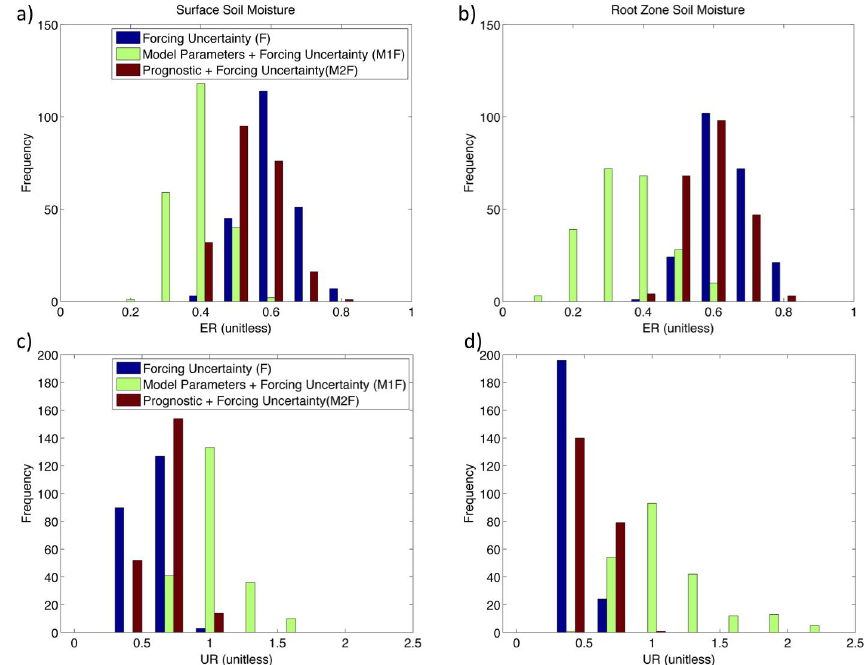
Figure 9 Frequency histograms of Exceedance Ratios (a, b) and Uncertainty Ratios (c, d) for surface soil moisture (a, c) and root zone 827 Fig. 9. Frequency histograms of exceedance ratios (a, b) and uncertainty ratios (c, d) for surface soil moisture (a, c) and root zone soil soil moisture (b, d). 828 moisture (b, d)